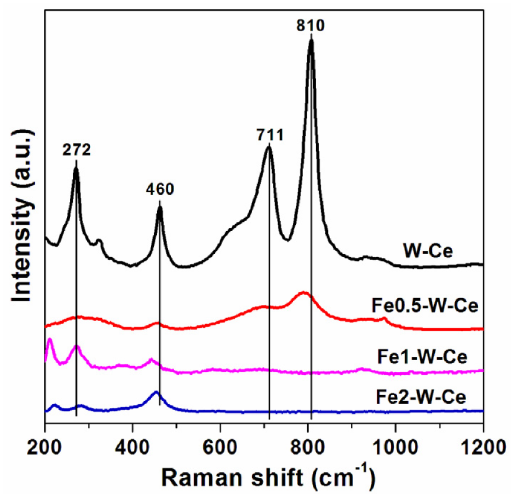
Figure 3. Raman patterns of Fe-W-Ce catalysts.